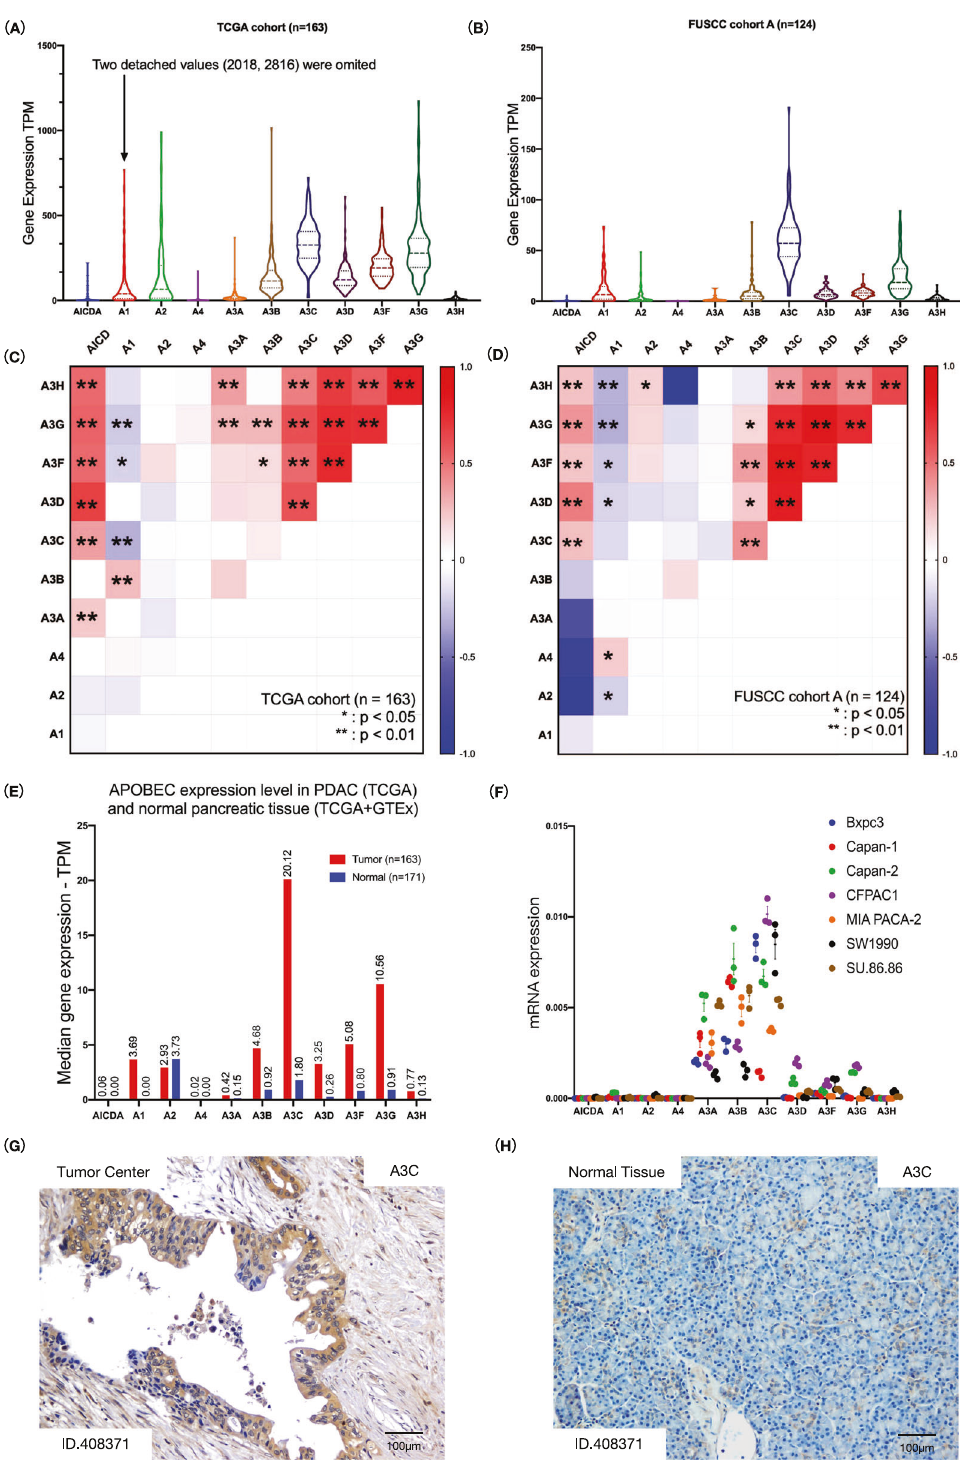
Fig. 2 APOBEC3C is expressed at the highest level among APOBECs in PDAC. A , B The mRNA expression levels of APOBECs in TCGA ( n = 163) and FUSCC cohort A ( n = 124). C , D The Pearson correlation coef fi cients were calculated to examine the correlations between APOBEC expression in TCGA cohort ( C ) and FUSCC cohort A ( D ). * p < 0.05, ** p < 0.01. Detailed information was shown in Table S5. E The height of the bar represents the median mRNA expression level of a speci fi c APOBEC. GEPIA2 normalised data by the maximum median expression value across all blocks and then compared data between pancreatic tumour tissues (TCGA database, n = 163) and normal tissues (TCGA and GTEx databases, n = 171) using one-way ANOVA, * p -value < 0.01. Corresponding box plots are displayed in Fig. S3. F Expression of APOBEC enzymes in PDAC cell lines. The mRNA expression level was determined by performing qRT – PCR on validated cDNAs in triplicate. G , H Representative images (patient ID.408371, FUSCC cohort B1) of IHC staining for APOBEC3 in PDAC ( G ) and normal pancreatic tissues ( H ). Normal pancreatic tissues from six patients with PDAC were stained, and the results are presented in Fig. S4. PDAC, pancreatic ductal adenocarcinoma; TPM: transcripts per million mapped